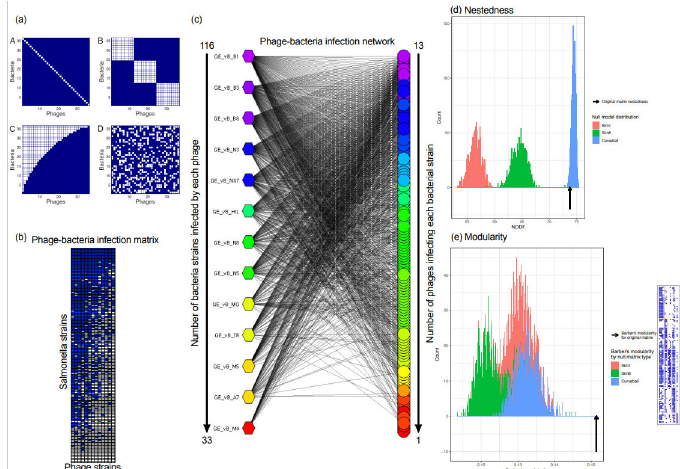
Figure 5. Investigation of the structure of the Salmonella phage–bacteria infection network. ( a ) Expected host–phage interaction matrices (adopted by [8]). Bacteria–phage interactions can be ( a ) A—unique; B—modular; C—nested; D—random. ( b ) The Salmonella phage–bacteria infection matrix (PBIM): Rows—Salmonella bacterial strains arranged with decreasing order based on the number of different phage species that can be infected by. Columns—phage species arranged with decreasing order based on the number of different Salmonella bacterial strains that can infect. Color coding: blue—infection, white—no infection. ( c ) The Salmonella PBIN; the network is arranged in accordance with the data from the PBIM. Circular nodes—Salmonella bacterial strains; polygonal nodes—phage species. Color coding—high (pink) to low (red) number of interactions (infections). Color coding refers to phage and bacterial node degree (number of successful infections), respectively. ( d ) Analysis of nestedness in the Salmonella PBIN. Distributions of nestedness scores (NODF) for the three null models (1200 simulations each) are shown, with the arrow indicating the score for the observed matrix. A NODF score for the observed matrix greater than 95% of the null matrix scores indicates the observed data is significantly nested ( p < 0.05). Null models: red—Sim1; green—Sim 8; blue—Curveball. ( e ) Analysis of modularity in the Salmonella PBIN. Distributions of modularity scores for the three null models (1200 simulations each) are shown, with the arrow indicating the score for the observed matrix. A modularity score for the observed matrix greater than 95% of the null matrix scores indicates the observed data is significantly modular ( p < 0.05). Matrix visual- ization of the module assignment giving the highest modularity score. Red—Sim1; green—Sim 8;